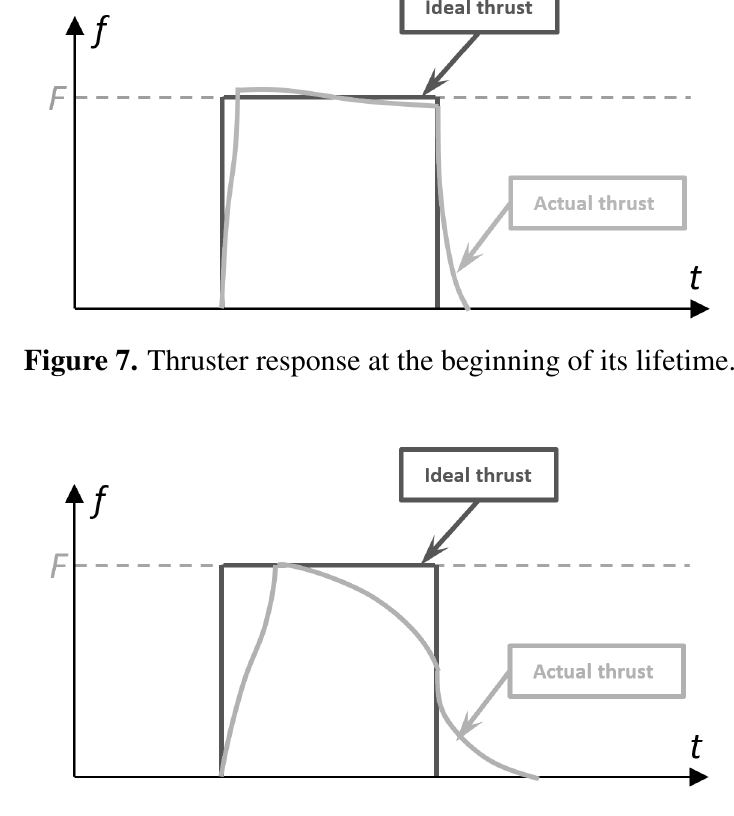
Figure 8. Thruster response at the end of its